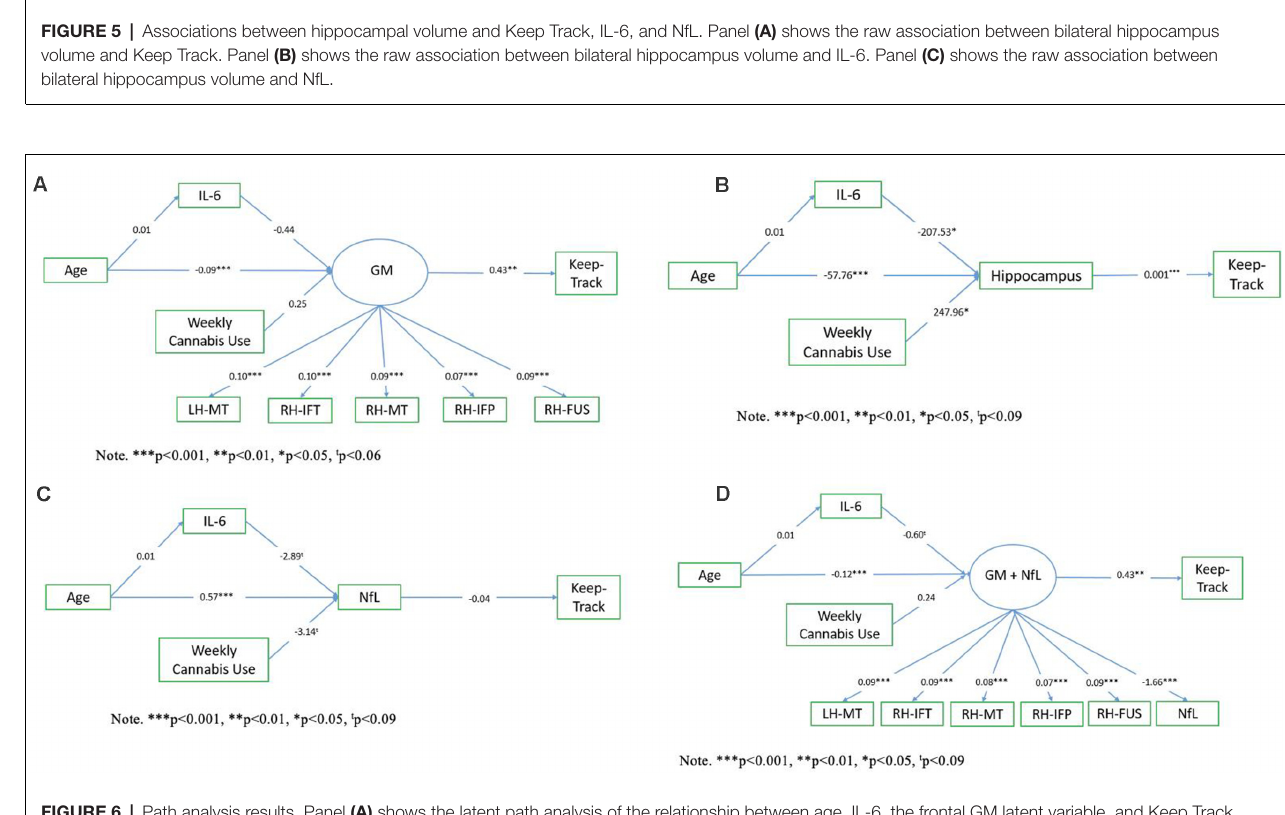
a biomarker indicative of neuronal damage (Hsiao et al.,